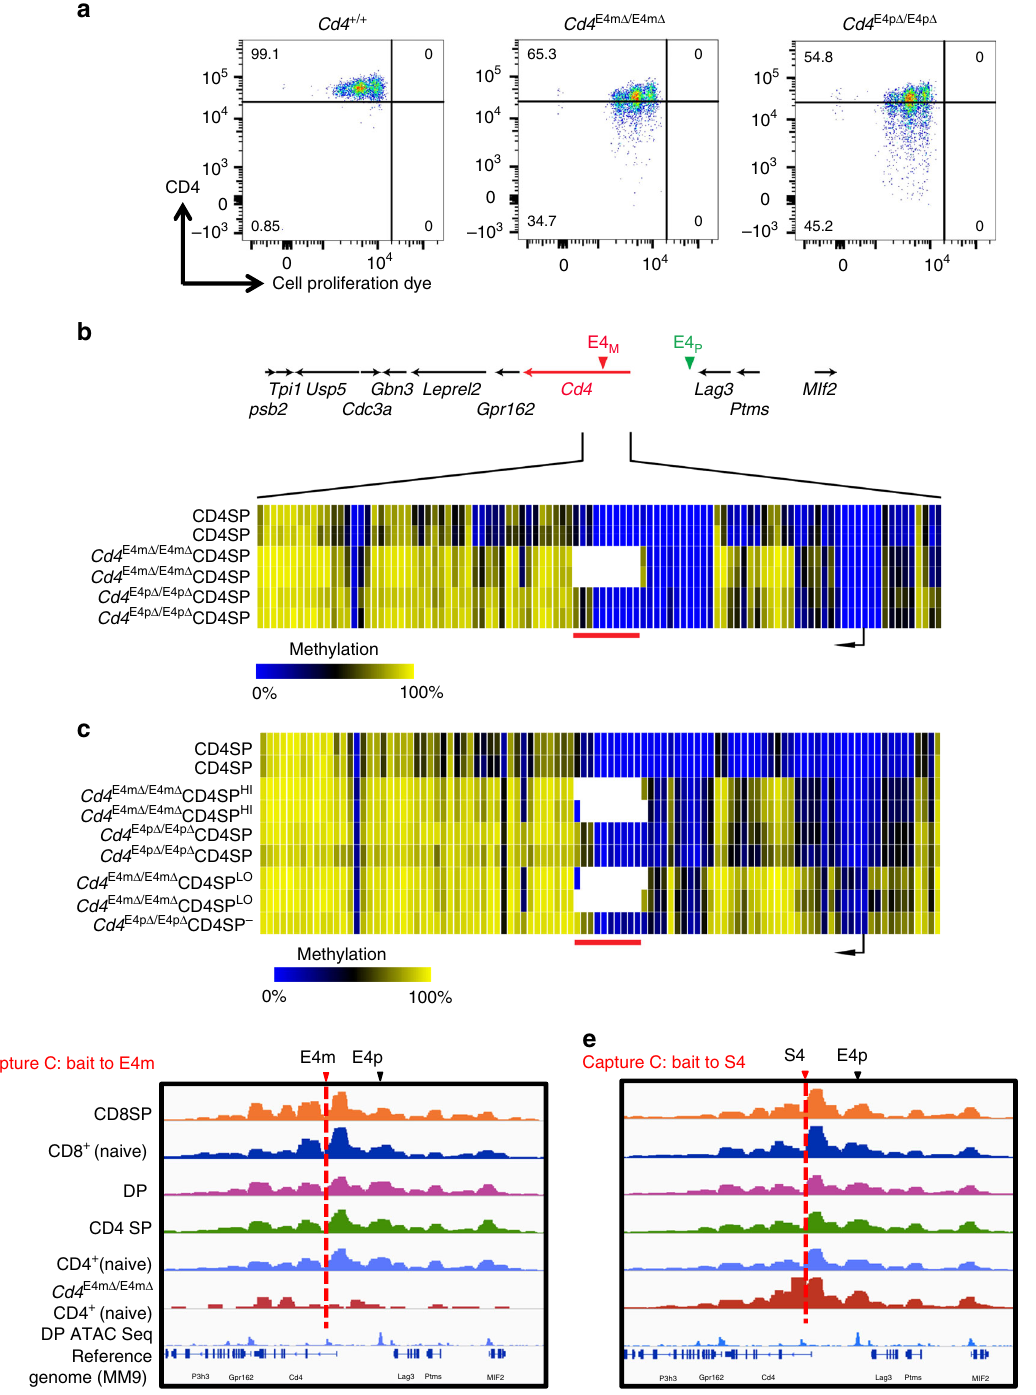
Fig. 5 E4m and E4p are both required for DNA demethylation necessary for stable Cd4 expression. a CD4 expression as a function of cell proliferation at 72 h after in vitro activation with anti-CD3/anti-CD28 of sorted naive CD4 + T cells from mice with the indicated genotypes. Cells were loaded with cell proliferation dye before activation. Numbers in the indicated gates represent cell percentages. Data are representative of more than three independent analyses. b , c Heatmaps depicting percent CpG methylation in WT CD4 SP, Cd4 E4m Δ /E4m Δ CD4 SP, and Cd4 E4p Δ /E4p Δ CD4 SP thymocytes for CpGs from + 6200 to − 669 relative to the Cd4 TSS (Chr6:124832027 – 124838896; mm9). A red line underlines CpGs in E4m (indicated by the gap in the mutant mice) and a black arrow indicates the Cd4 TSS. CATCH-seq was performed on genomic DNA from sorted populations of TCR β hi CD24 lo CD69 − CD4 + CD8 − thymocytes. In c , naïve CD4 + T cells from mice with the indicated genotypes were sorted, labeled with cell proliferation dye, and stimulated in vitro with anti-CD3/anti-CD28, and cells were sorted 5 days later based on their CD4 expression (high vs. low) for CATCH seq. Replicates were derived from two independent experiments. Note data for Cd4 E4p Δ /E4p Δ conditions were from previously published experiments with similar experimental conditions 9 . d , e Overlaid normalized mean Capture-C pro fi les from indicated cell types with MM9 ATAC-seq dataset from DP thymocytes. The captured E4m and S4 viewpoint fragments are highlighted with the dotted red lines and the interactions with E4p are indicated with black arrows. Data were normalized using DESeq2 using 2 kb sliding window (slide by 100